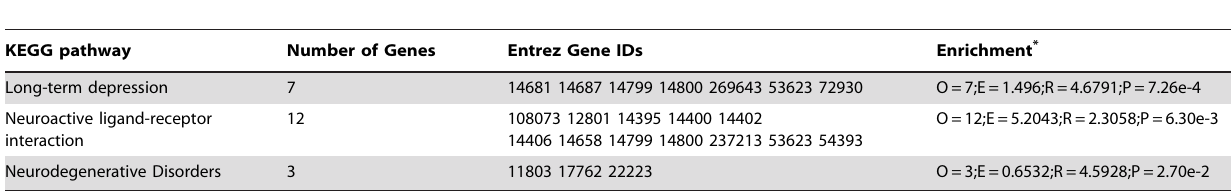
* Abbreviations used in the ‘‘Enrichment’’ column: O: observed, E: expected, R: enrichment ratio, and P: hypergeometric p -value for enrichment.